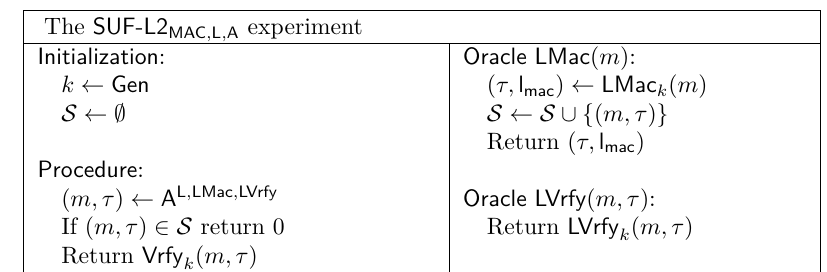
Table 2: The SUF - L2